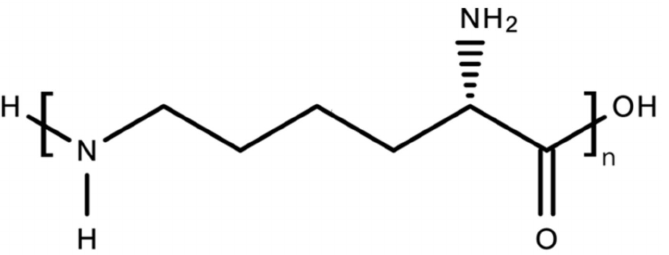
Figure 15. The polymeric structure of ε -poly- L -lysine, where n is integer of the repetition